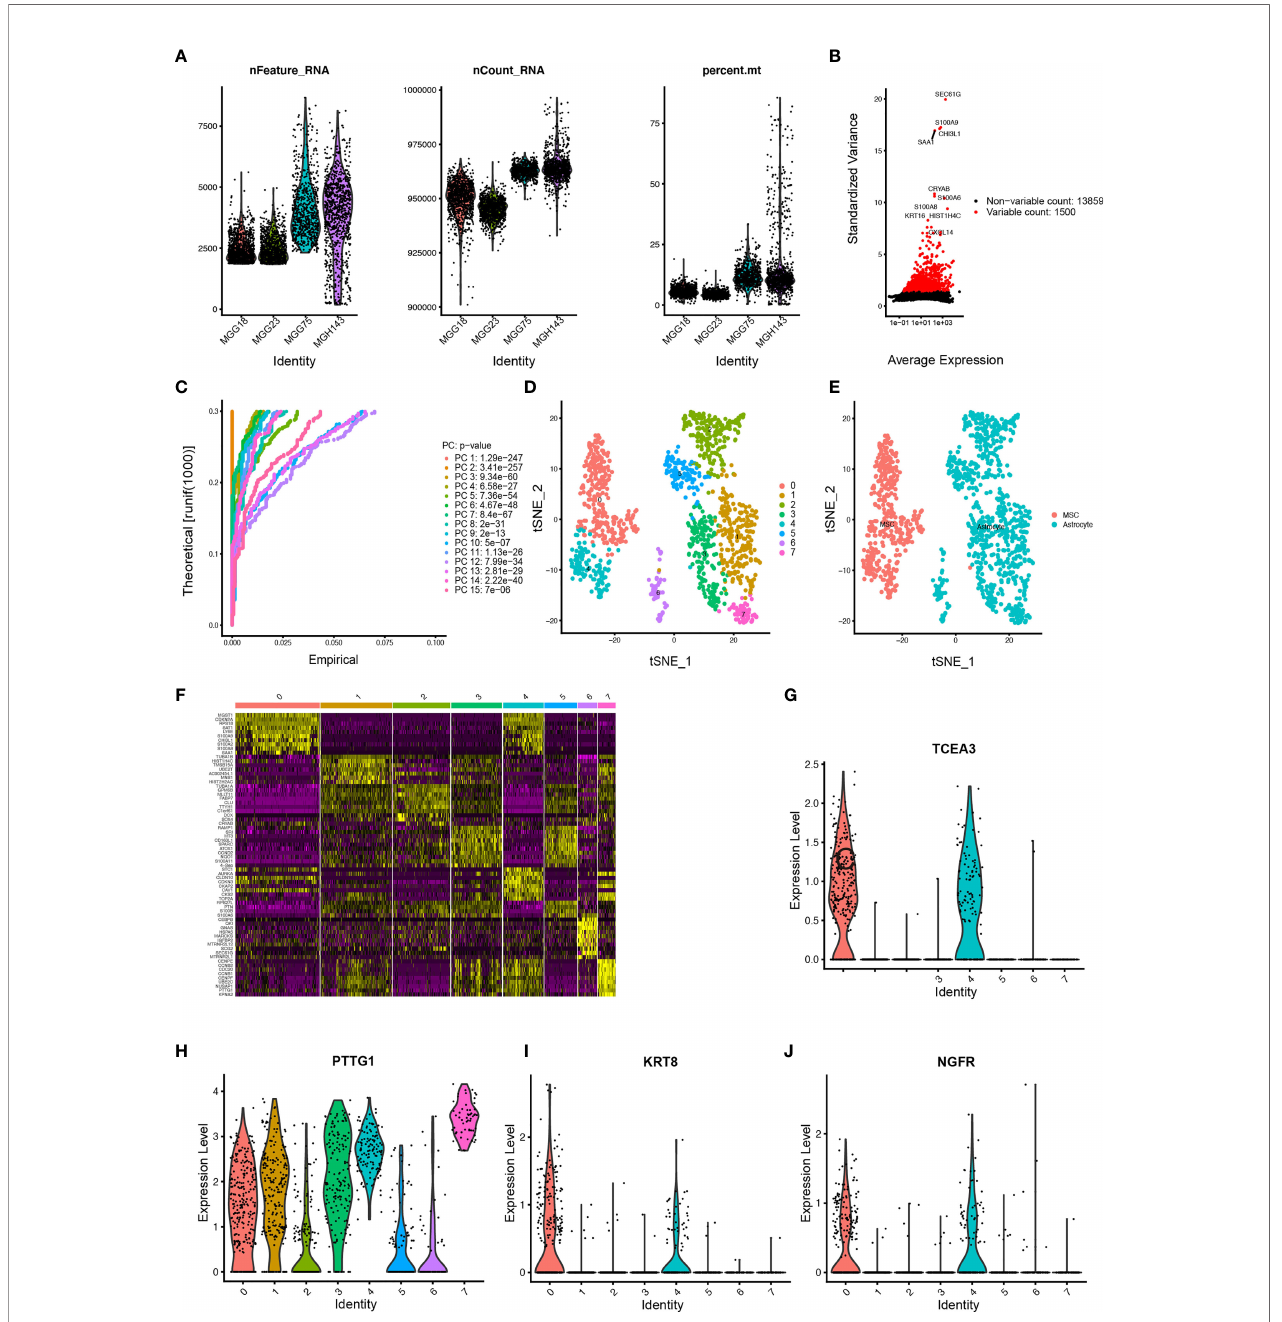
FIGURE 7 | Estimation of tumor-in fi ltrating cells for GBM subtypes based on scRNA-seq data (A) After quality control of the 3,483 cells from the tumor cores of 4 human GBM samples, 1,190 cells were included in the analysis. (B) The variance diagram shows 13,859 corresponding genes throughout all cells from GBMs. The red dots represent highly variable genes, and the black dots represent nonvariable genes. The top 10 most variable genes are marked in the plot. (C) PCA identi fi ed the 15 PCs with an estimated p value < 0.05. (D) All eight clusters of cells in GBMs were annotated by singleR and CellMarker according to the composition of the marker genes. (E) The tSNE algorithm was applied for dimensionality reduction with the 20 PCs, and 8 cell clusters were successfully classi fi ed. (F) The differential analysis identi fi ed 4,210 marker genes. The top 20 marker genes of each cell cluster are displayed in the heatmap. A total of 68 genes are listed beside of the heatmap after omitting the same top marker genes among clusters. The colors from purple to yellow indicate the gene expression levels from low to high. (G – J) Expression pro fi les of the four risk genes in eight cell